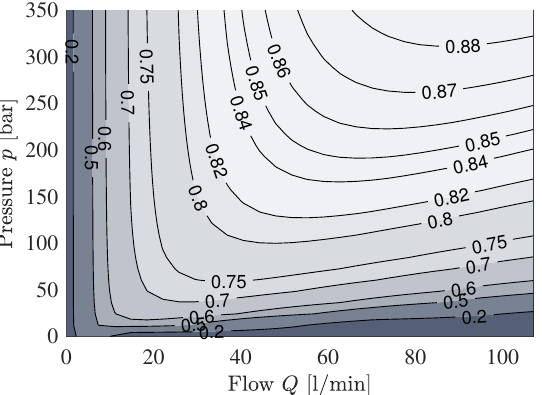
Figure 23. Pump total efficiency η as a function of pressure and flow with estimated parameters. During operation the pump pressure and pump flow are functions of the load sensing pressures and actuator flows, given in Equations (25) and (26). A margin pressure p margin is added to the pump pressure setting. This is to ensure the pressure compensator has some headroom to adjust the pressure drop over the directional control valve. A consequence of this margin pressure is the poor efficiency seen when the load pressures are low. The margin pressure typically ranges from 10 bar to 30 bar, and p margin = 20 bar is used in this simulation.